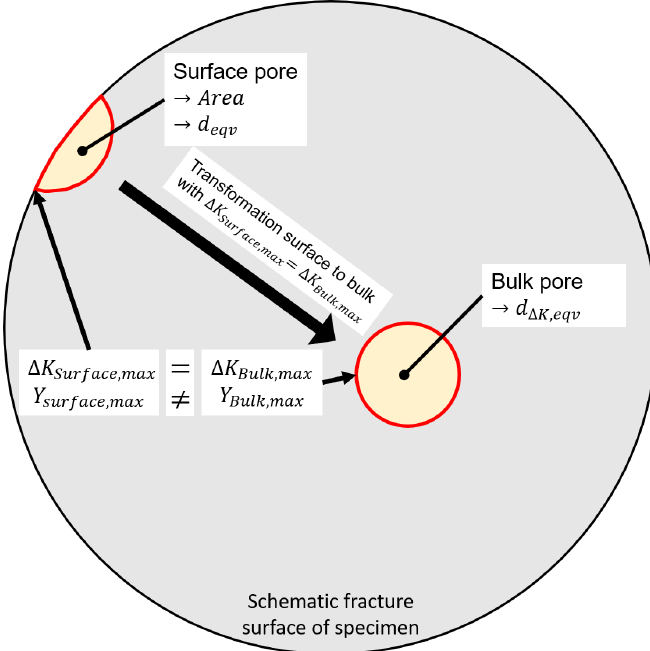
Figure 8. Schematic illustration of the surface to bulk pore transformation.